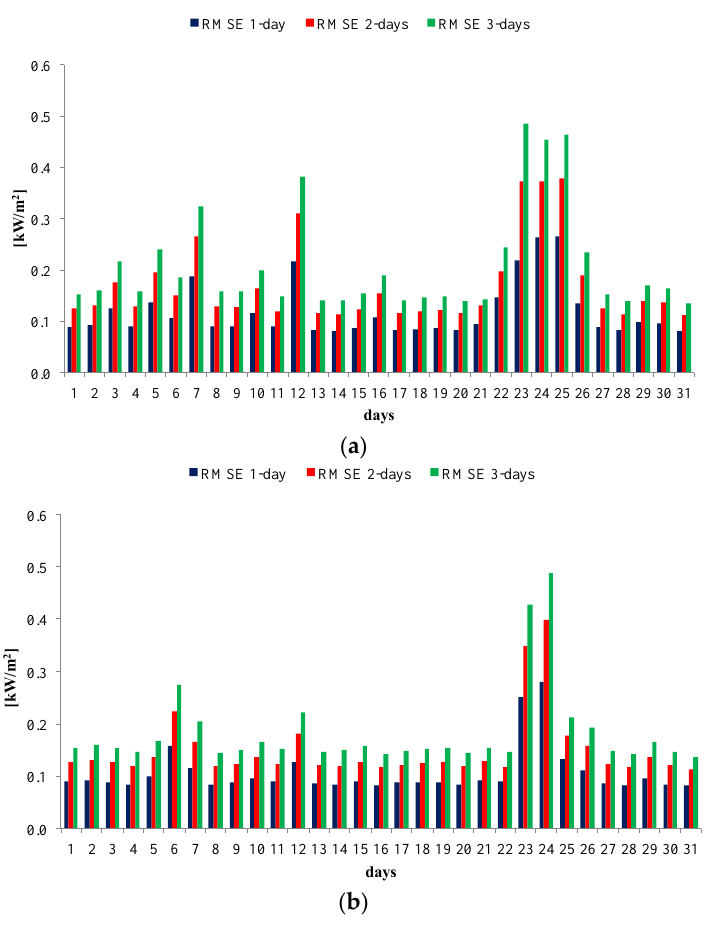
Figure 3. The RMSE in kW/m 2 in July. ( a ) Site “Gi”; ( b ) Site “Ma”.